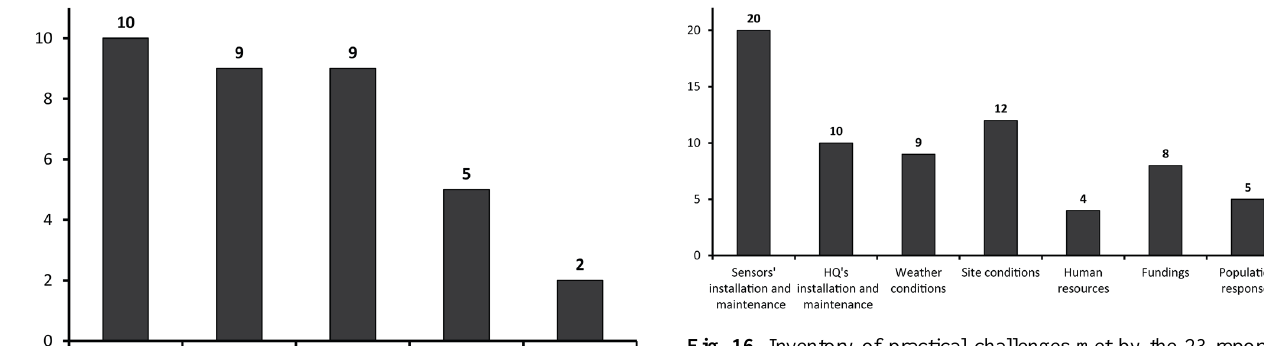
Fig. 16. Inventory of practical challenges met by the 23 reported EWSs. The total number of challenges is over 23, because EWSs usually encountered more than one issue during their life